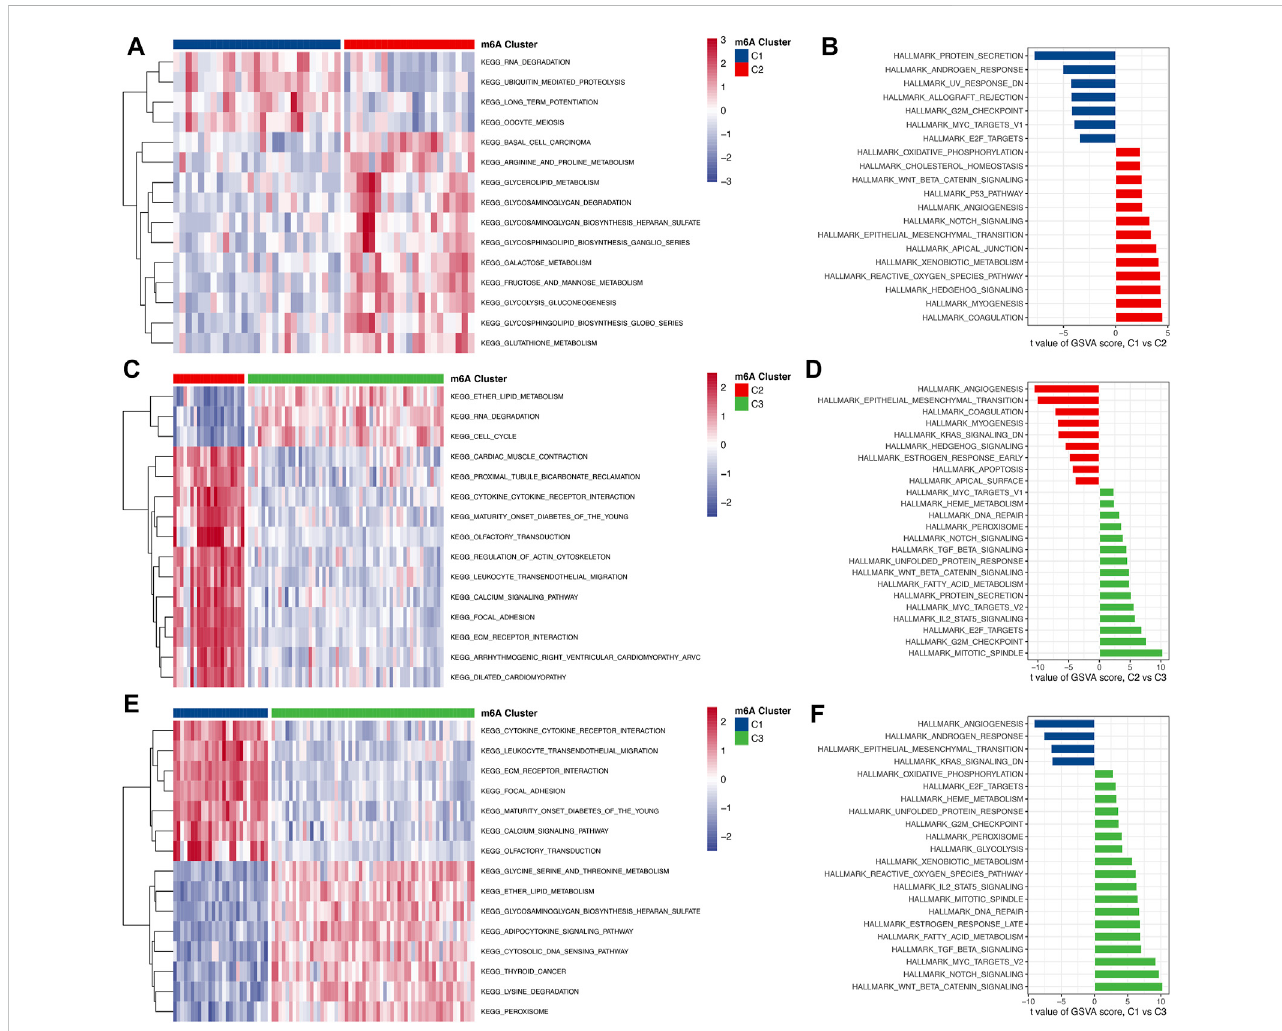
FIGURE 6 The biological function characteristics among the 3 m 6 A subtypes. (A,B) Differences in GSVA enrichment scores for the KEGG pathway and HALLMARK pathwaybetweenm 6 Acluster1andcluster2(AfortheKEGGpathwayandBfortheHALLMARKpathway). (C,D) DifferencesinGSVAenrichmentscoresforthe KEGG pathway and HALLMARK pathway between m 6 A cluster 2 and cluster 3 (A for the KEGG pathway and B for theHALLMARK pathway). (E,F) Differences in GSVA enrichment scores for the KEGG pathway and HALLMARK pathway between m 6 A cluster 1 and cluster 3 (A for the KEGG pathway and B for the HALLMARK